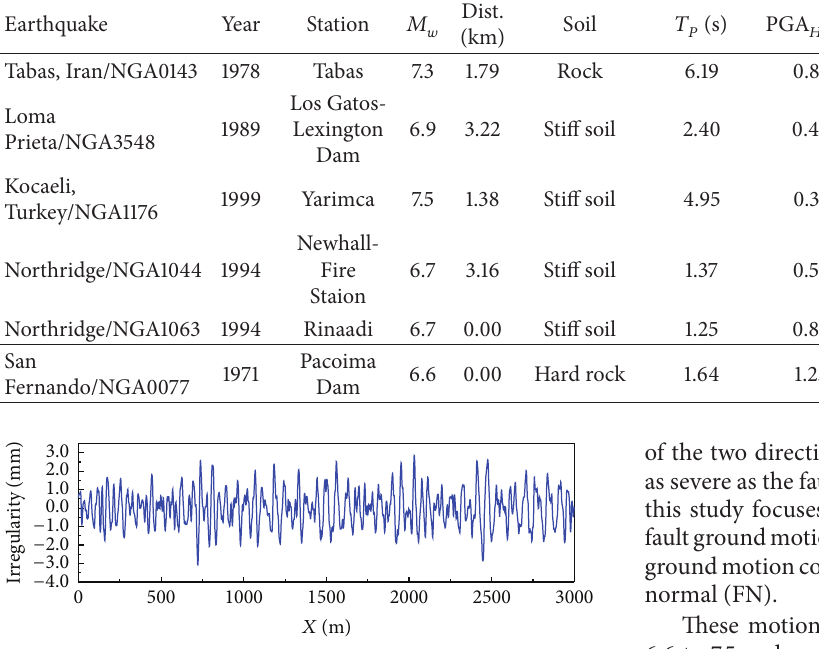
Figure 6: Vertical elevation track irregularity